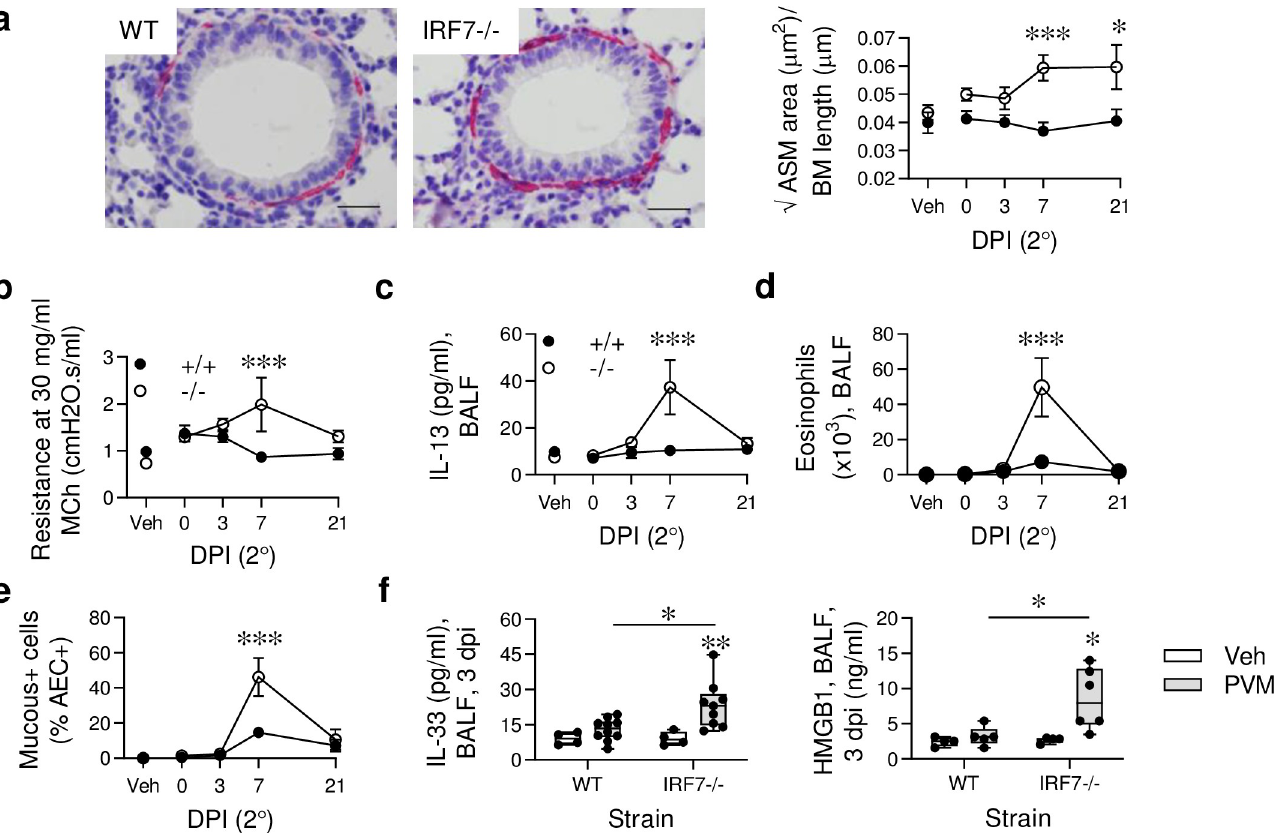
Fig 3. Secondary Pneumovirus infection promotes an asthma-like pathology in IRF7-deficienct mice. WT (IRF7 +/+ ) and IRF7 -/- mice were inoculated with PVM at postnatal day 7 and re-infected 6 weeks later. Samples were collected prior to re-infection (t = 0) and at 3, 7 and 21 dpi. (a) Representative micrograph (x400 magnification) of α -smooth muscle actin immunoreactivity (red) in the lung at 7 dpi and ASM area quantification. Bars, 20 μ m. (b) AHR at 30 mg/ml of methacholine. (c) IL-13 protein levels in BALF. (d) Total eosinophil numbers in BALF. (e) Mucus-producing airway epithelial cells (AECs). (f) IL-33 (left) and HMGB1 (right) protein expression in BALF at 3 dpi. Data are representative of n = 2 experiments with 4–9 mice in each group and are presented as mean ± SEM (a ([right], b—e) or as box-and-whisker plots showing quartiles (boxes) and range (whiskers; f). Data were analyzed by Two-way ANOVA with Tukey post hoc test (a ([right], b—e) or One-way ANOVA with Dunnett post hoc test (f); � , P < 0.05; �� , P < 0.01; ��� , P < 0.001 compared with the WT control group.